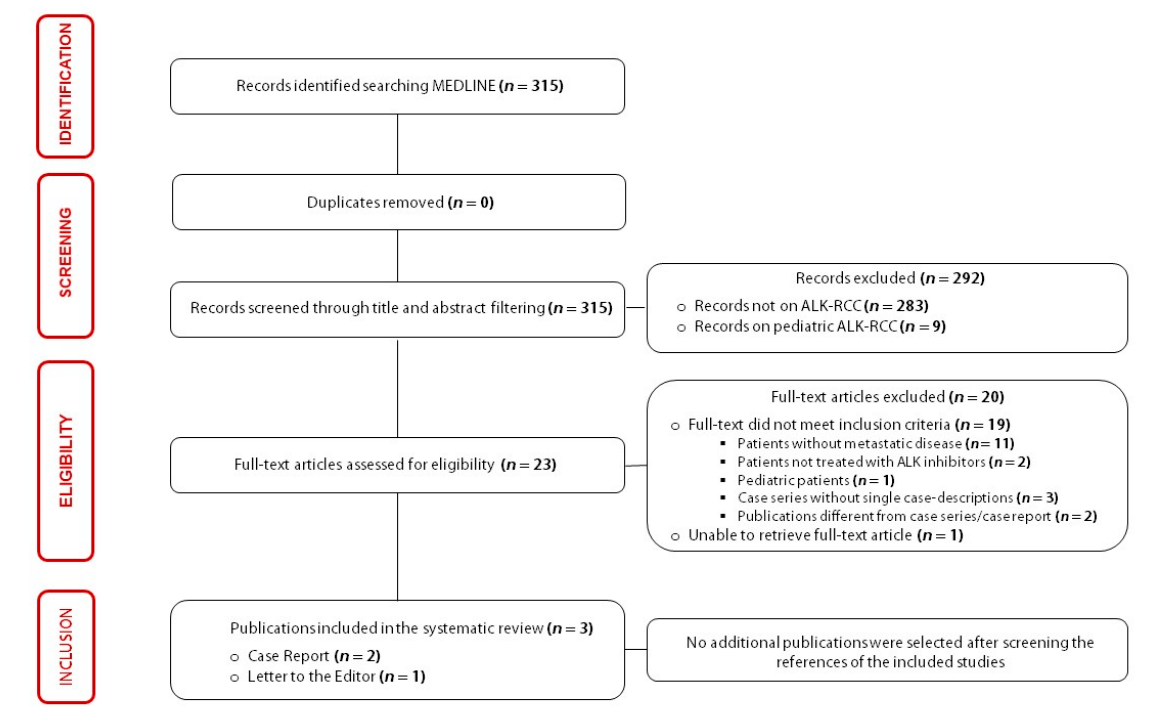
Figure 2. Flowchart of the results of literature search and identification process of included